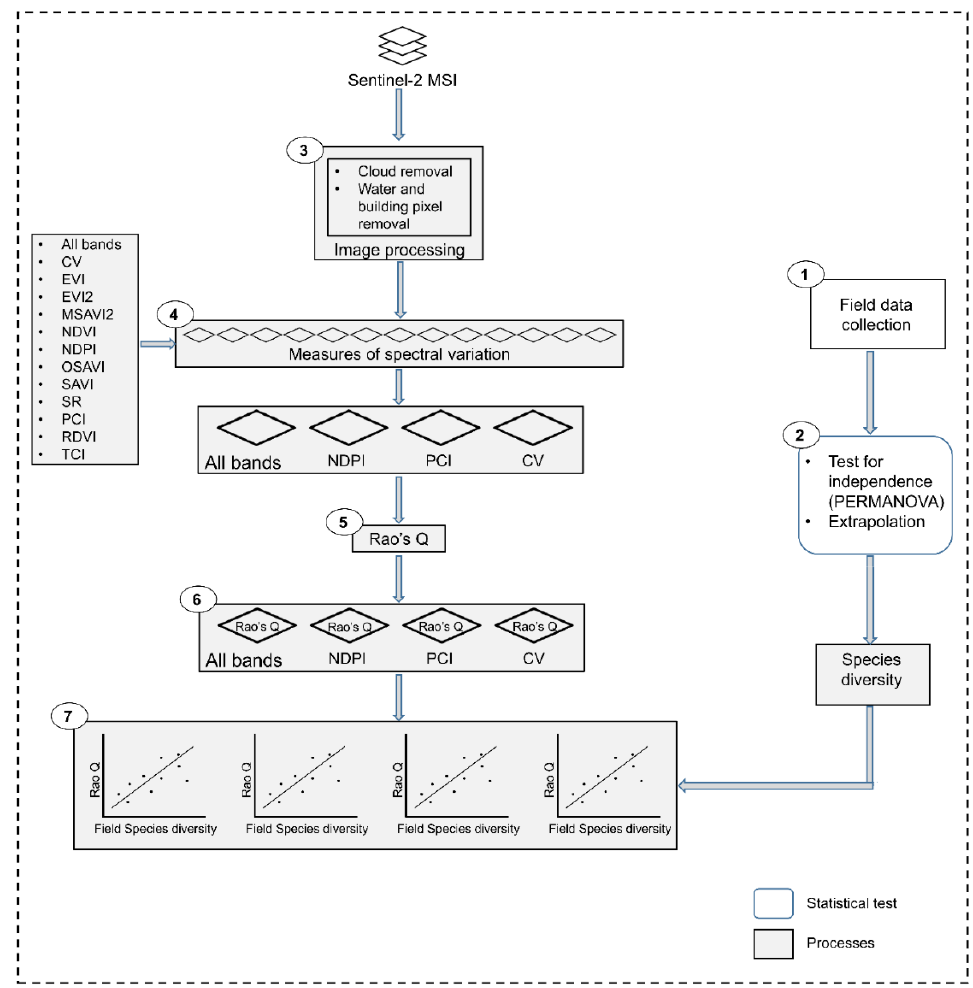
Figure 3. Summarised flowchart of the steps and processes followed to characterise vegetation diversity in the Khakea-Bray TBA. The numbers show the main steps